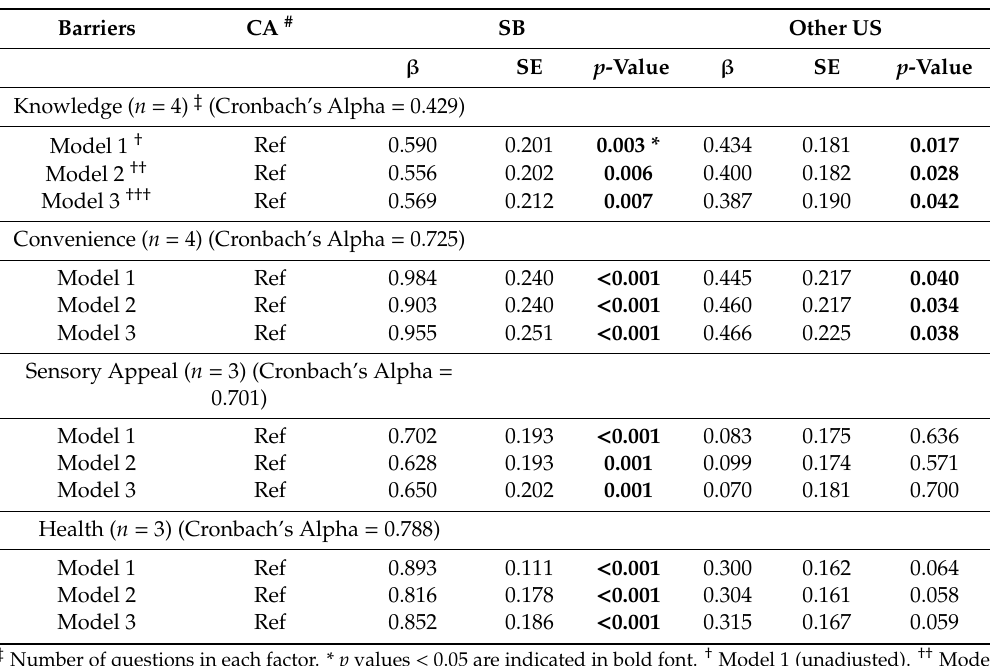
Table 3. Multivariate linear analysis of MedDiet barriers across geographic